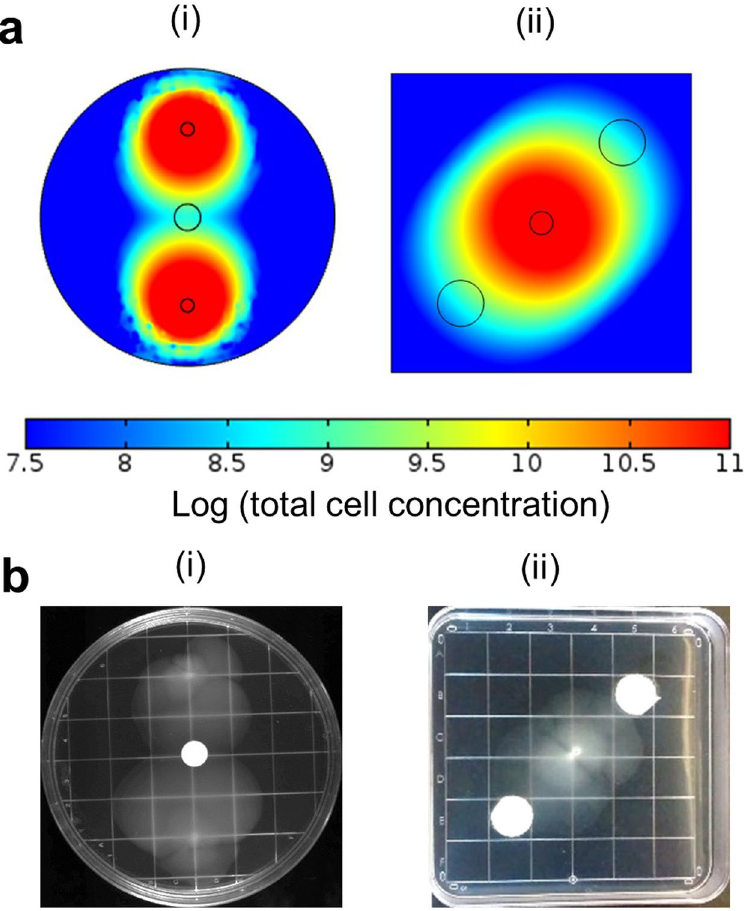
Figure 5. Predictive design and experimental verification of motility-induced pattern formation: ( a ) Results from simulation of the patterns formed by cells in response to different spatial arrangements of signals and starting inoculum of cells. (i) 3.5 * 10 7 CoMot + cells/m 2 were used as the inoculum at opposite edges of a circular plate and a gradient was established using 85 μ moles/m 2 of the signal at the centre of the plate. 85 μ moles/m 2 of the signal is equivalent to an experimental 3OC6HSL concentration of 500 nM. Images were obtained after a simulation time of 36 h. (ii) 3.5 * 10 7 CoMot + cells/m 2 were used as the inoculum at the centre of a square plate in which the signal gradient was established using two signal sources along a diagonal. 85 μ moles/m 2 of the signal was used for each source to establish the gradient. Images were obtained after a simulation time of 36 h. ( b ) Experimental verification of patterns predicted by the model. (i) The equivalent of 500 nM of 3OC6HSL was added on a membrane 12 h prior to inoculation of CoMot + cells at opposite edges of the plate. (ii) Membranes with the equivalent of 500 nM of 3OC6HSL were placed along the diagonal of the plate 12 h prior to inoculation of CoMot + cells at the centre. Each pattern was experimentally verified in triplicate and representative images obtained after 36 h of incubation at 30 °C are